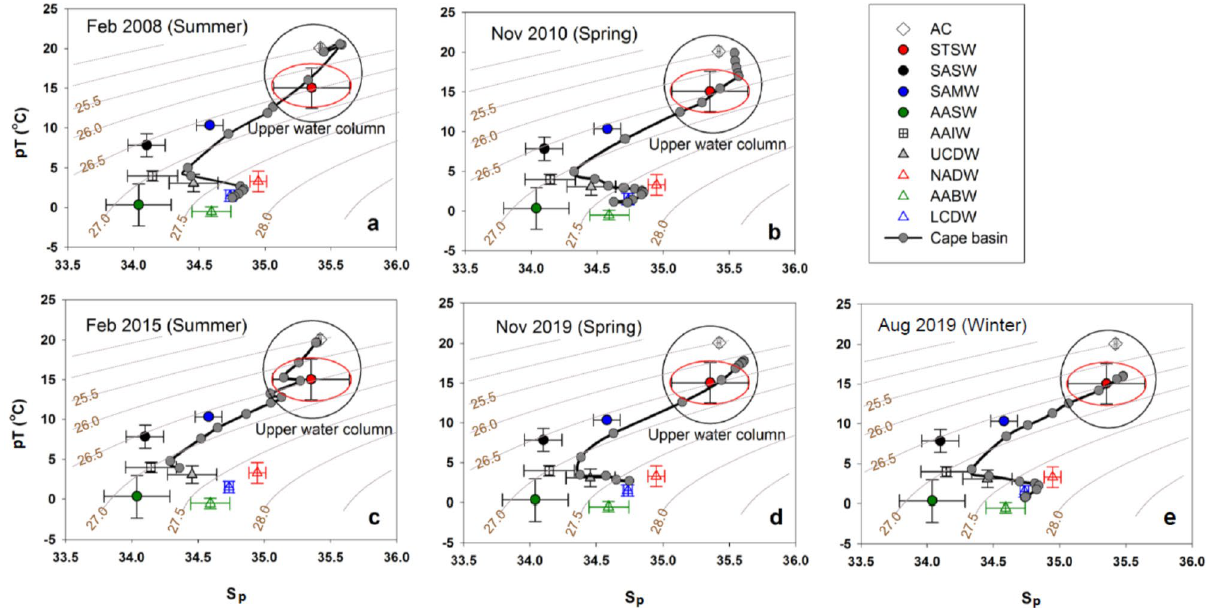
Figure 3. pT and Sp properties of the water column in the Cape Basin during ( a ) Feb 2008 31 , ( b ) Nov 2010 30 , ( c ) Feb 2015, ( d ) Nov 2019, and ( e ) Aug 2019. The data points that fall close to the STSW (red circle) and AC (open diamond, error bars within the symbol) correspond to the upper water column (ca. up to 400 m depth), located inside the black circle. The pT and Sp of identified water masses in the region are given in the “Methods” section. The red oval exhibits the boundary of STSW-rich